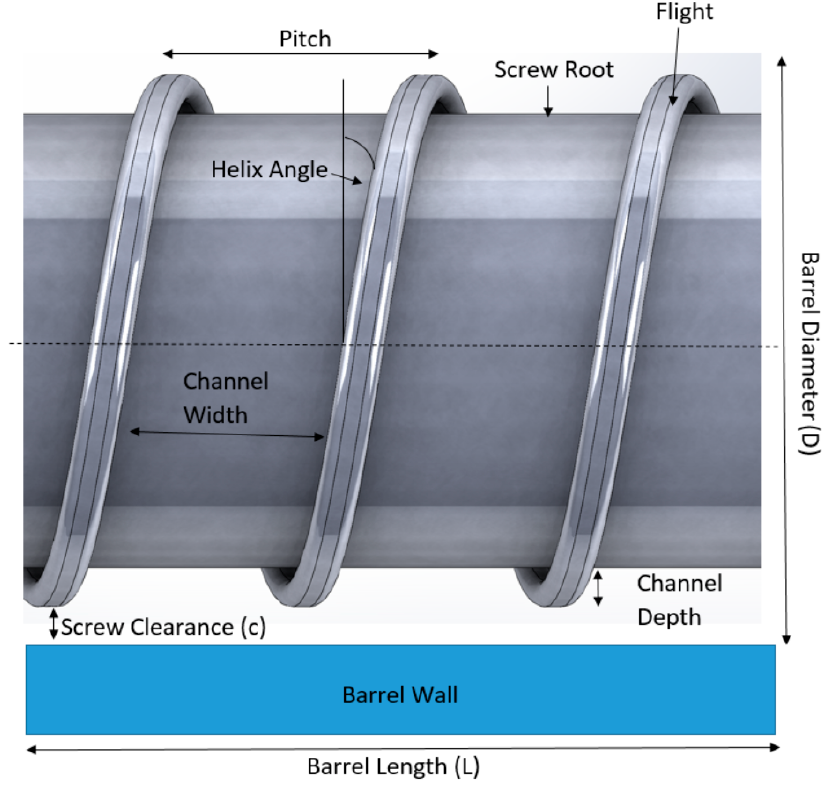
Figure 4. Parameters of a screw in a hot-melt extruder.